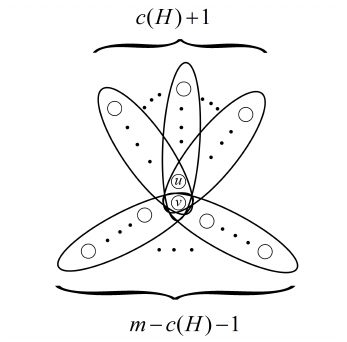
Figure 4. The k -uniform c ( H ) -cyclic hypergraph H 2